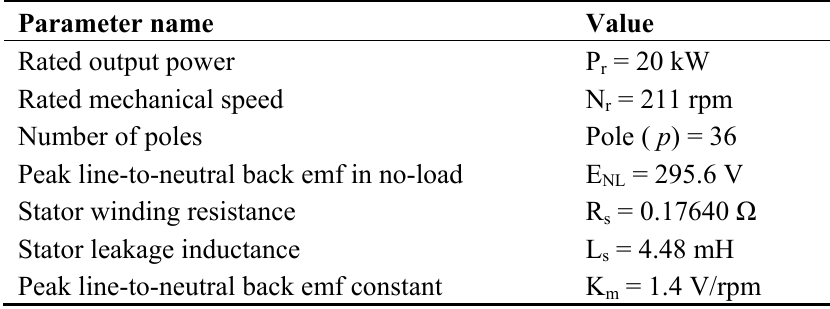
Figure 4. The generator side converter control strategy.